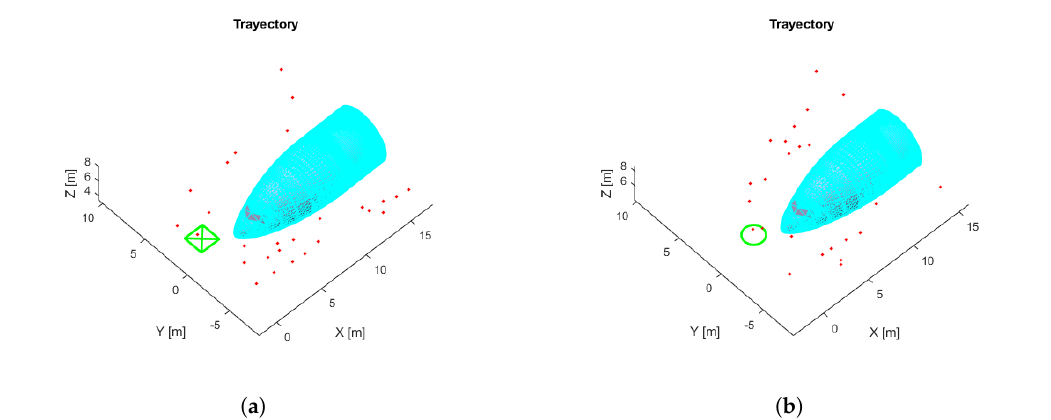
Figure 11. Proposed initial flight (green), Aircraft (cyan), take-off point (red). ( a ) Squared path. ( b ) Circular